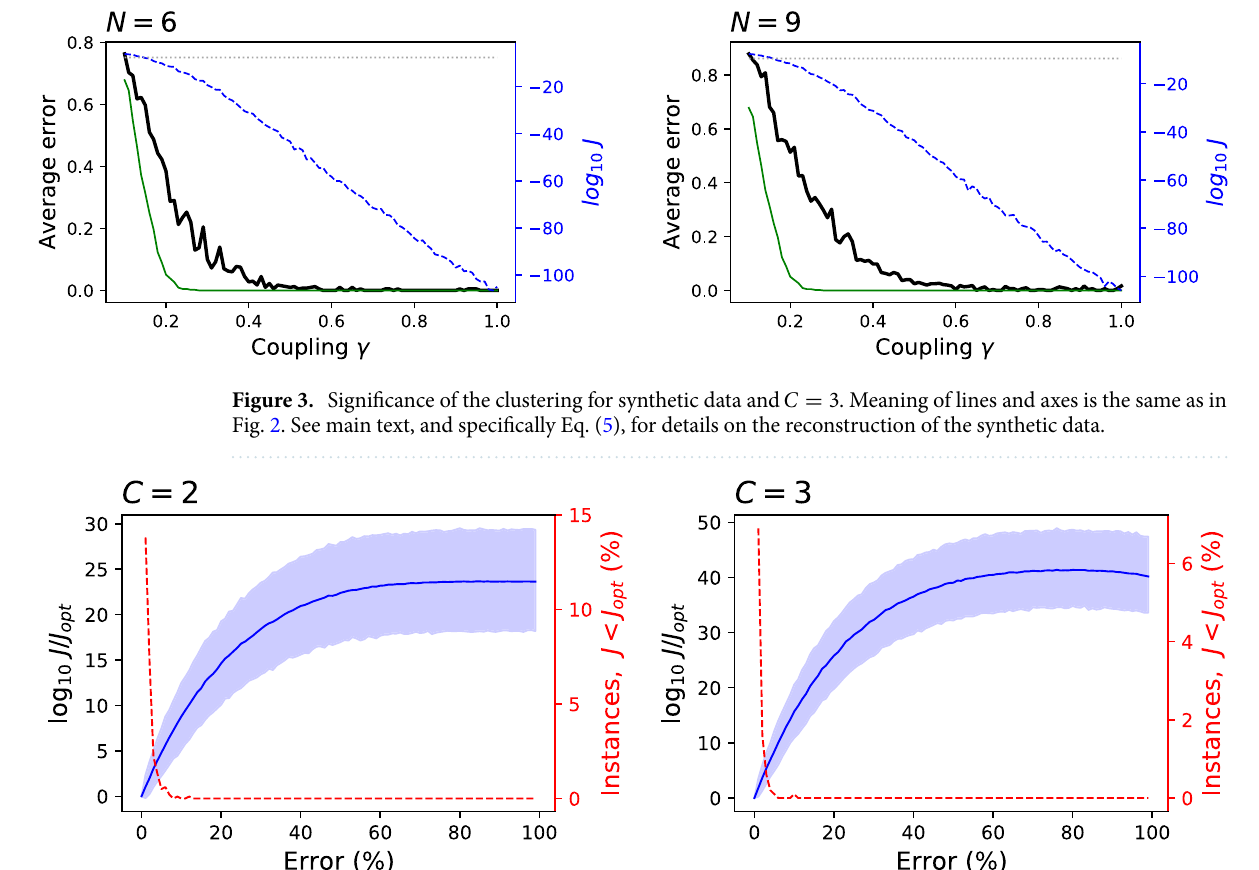
Figure 4. Relationship between J and the quality of the clustering. Both panels report the average (solid blue lines) and the 10 − 90 percentile interval (blue bands) of the metric log 10 J / J opt ; see main text for definition. The red dashed lines (right Y axes) report the percentage of random realisations for which J < J opt . Left and right panels respectively correspond to C = 2 and C = 3